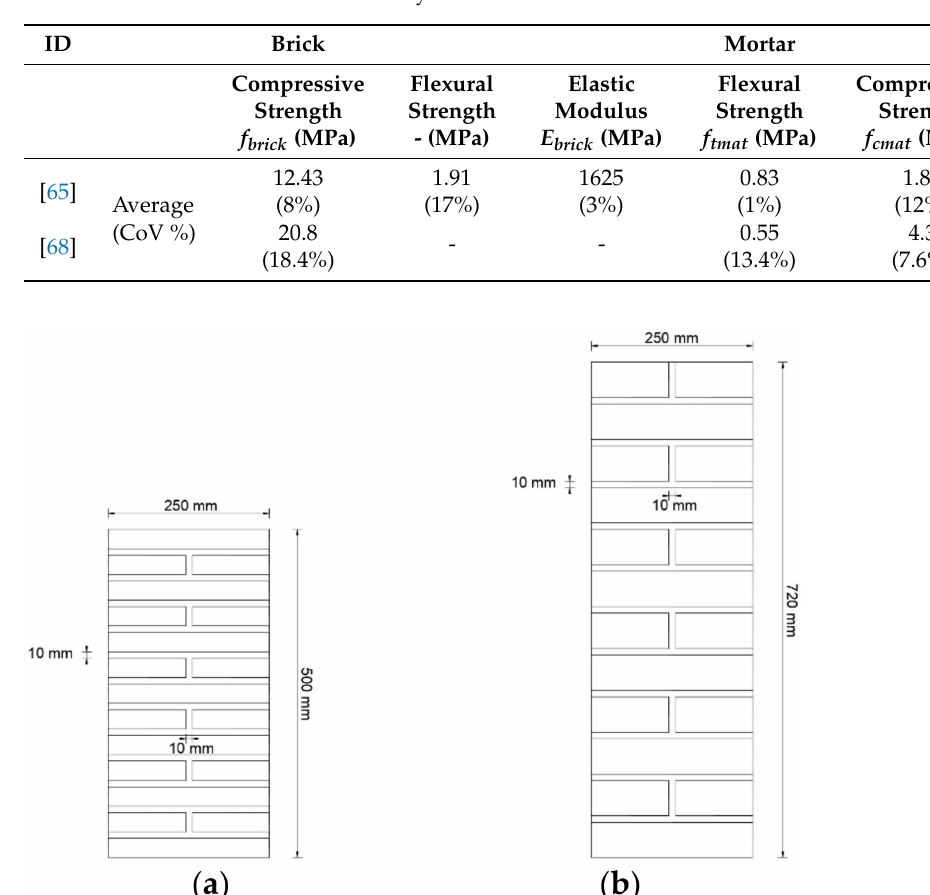
Table 1. Statistical values of the masonry’s constituents.